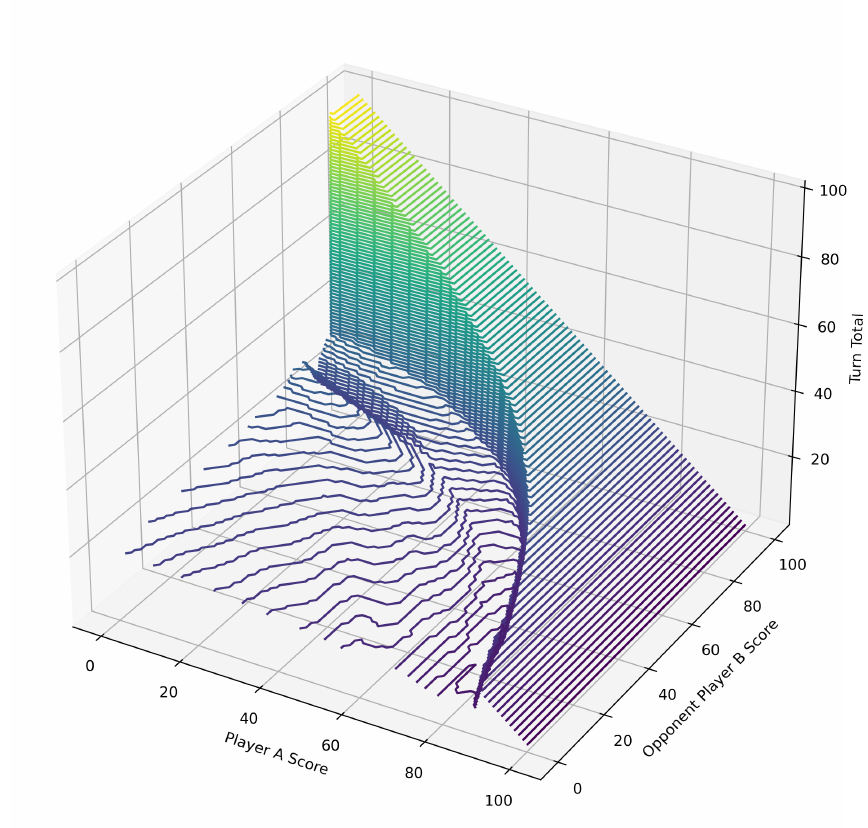
Figure 2. The roll/hold boundary for each state (Player A Score, Opponent Player B Score, and Turn Total) for Player A who goes first. The line shown is the boundary between states in which Player A should roll (below the line) and states in which Player A should hold (above the line).